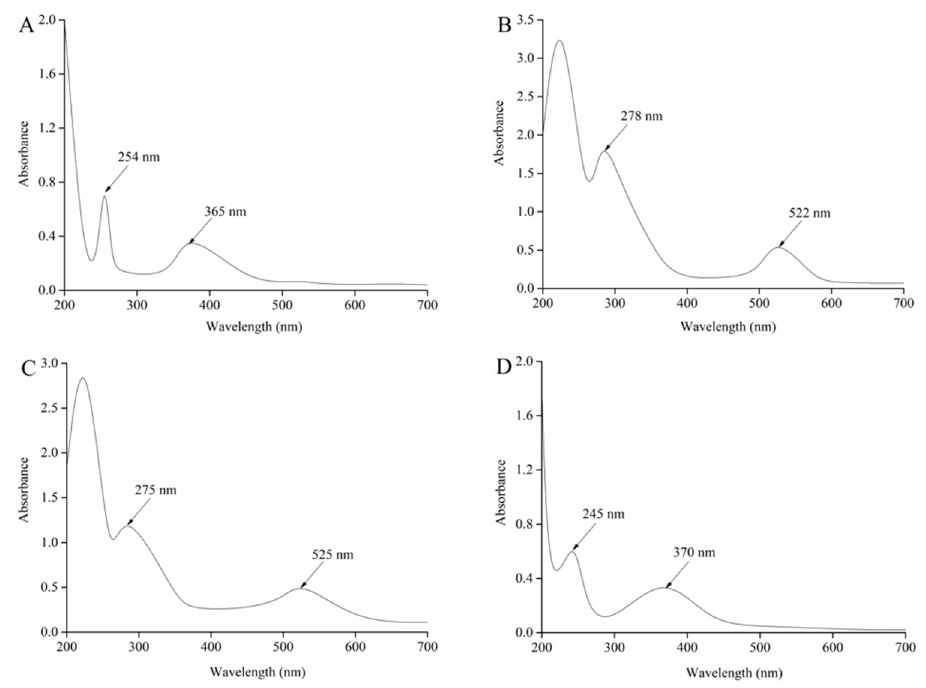
Figure 6. UV-vis spectra of component I ( A ), II ( B ), III ( C ) and IV ( D ) separated from raspberries by HSCCC.